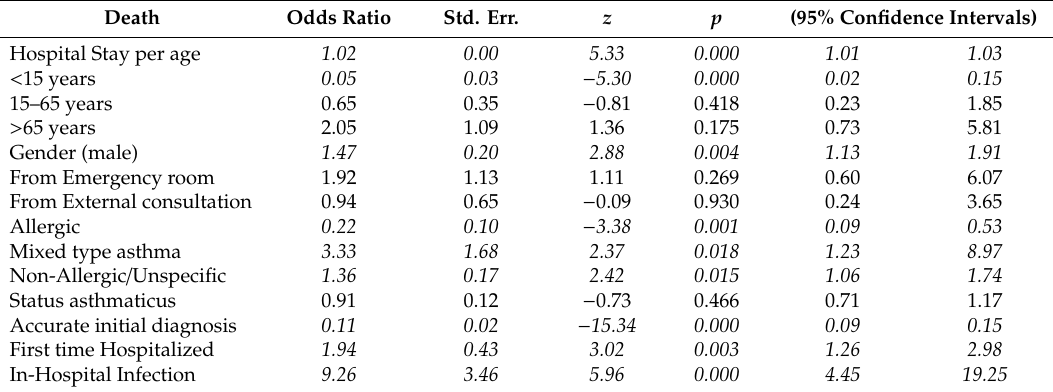
Table 4. Epidemiologic and Clinical characteristics associated to fatal outcome among patients hospitalized due to asthma in Mexico from 2010 to 2018 ( n = 87,726). Death Odds Ratio Std.